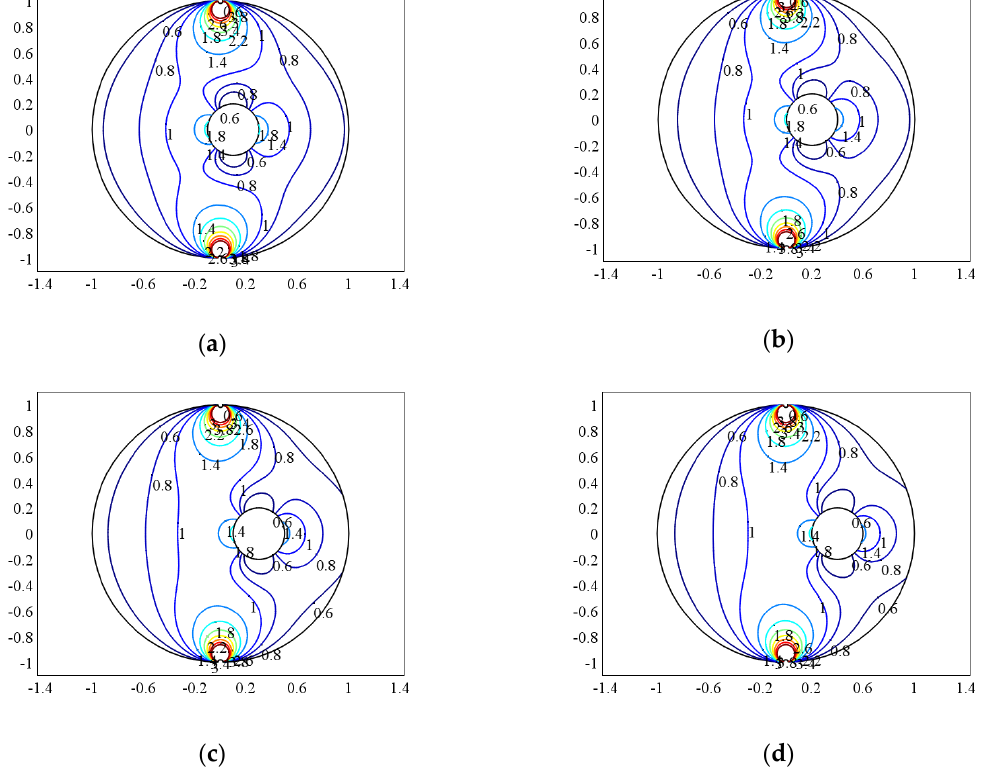
Figure 6. The weight function distribution at a = 0. ( a ) e = 0.1, ( b ) e = 0.2, ( c ) e = 0.3, ( d ) e = 0.4.